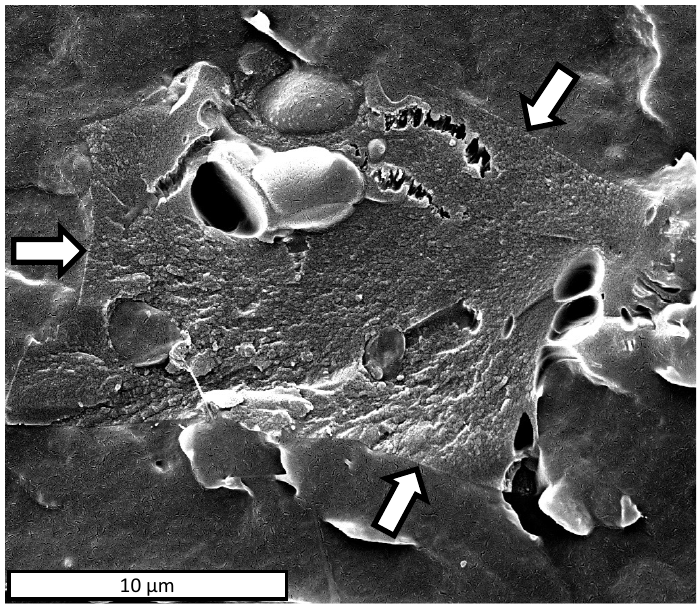
Figure 5. SEM micrographs of the PBAT–BC interface in a PBAT/BC 5% biocomposite. The arrows indicate the PBAT-BC interface.